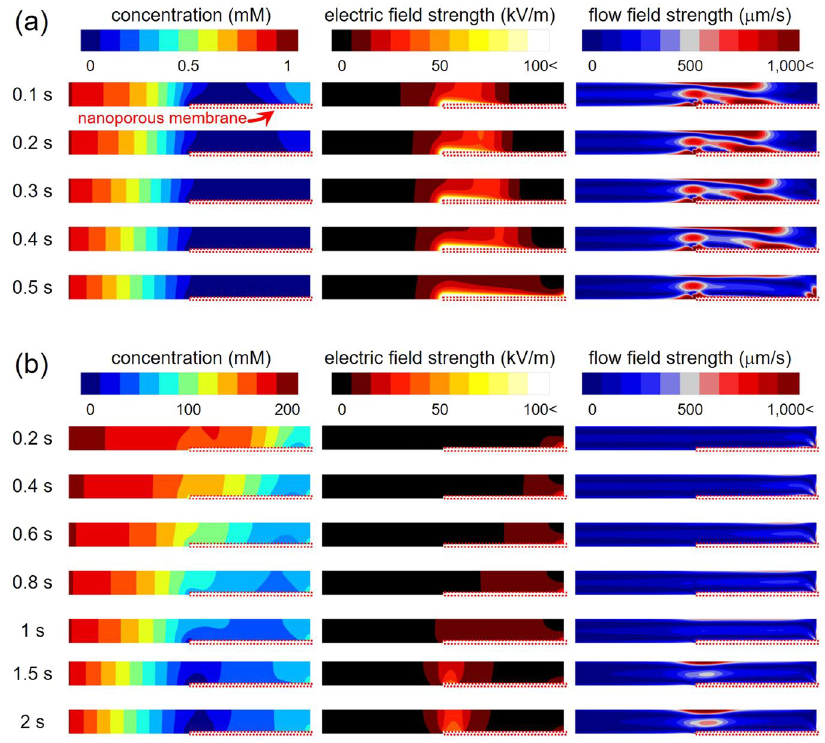
Figure 4. The numerically simulated spatiotemporal formation of the ion depletion zone in the case of ( a ) dilute limit and ( b ) condensed limit. The membrane charge concentration ( N ) was fixed at 100 mM. In each case, the bulk concentration was 1 mM and 200 mM